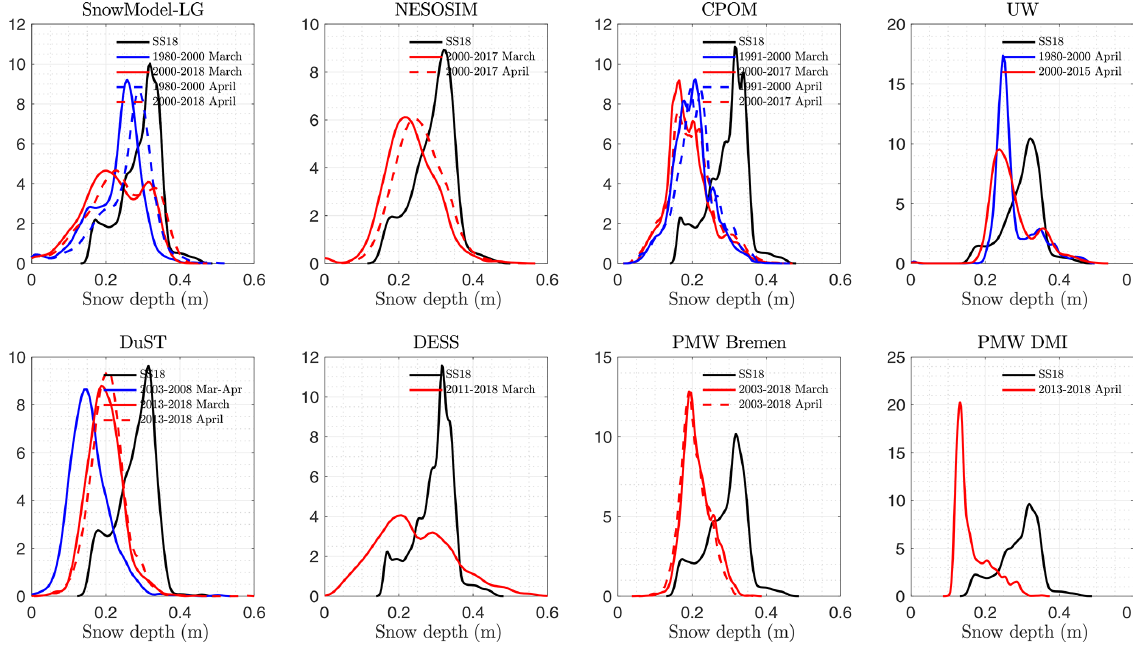
Figure 6. Snow distribution comparison between SS 18 climatology and snow products.